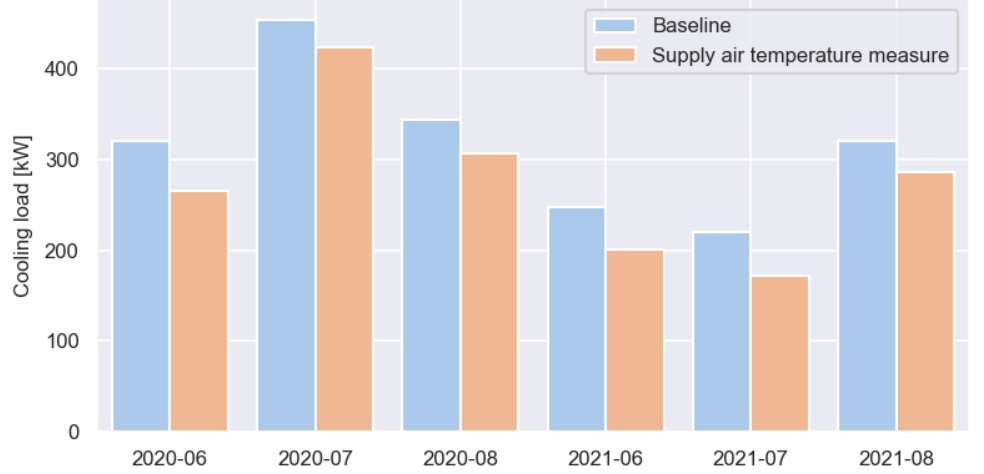
Figure 16. Average cooling load per month for the baseline and proposed supply air temperature